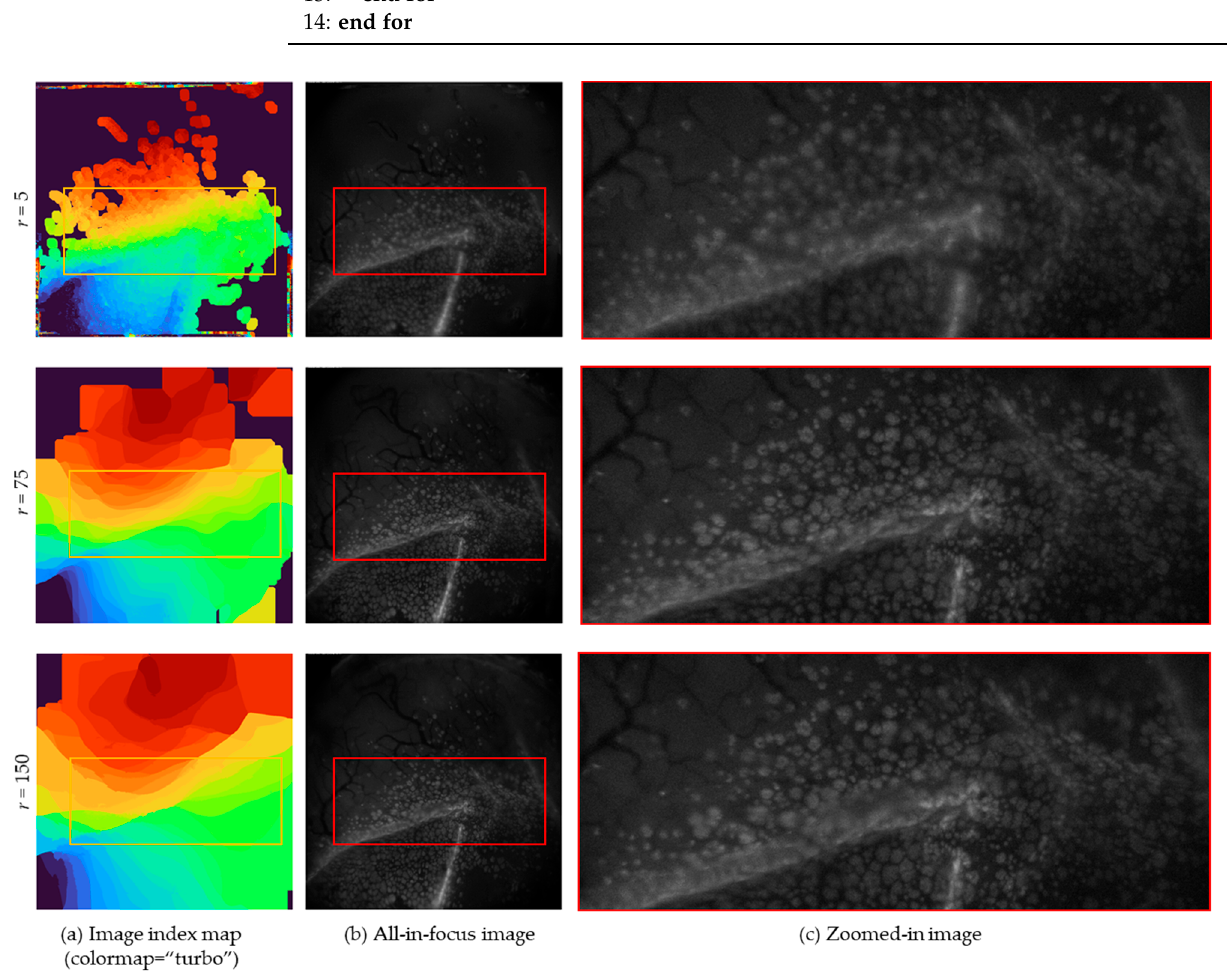
Figure 3. Image index map and processed results for different values of the window size r . Each column is separated by a r . ( b ) All-in-focus images that are fused based on image index maps in ( a ). The marked areas highlighted by the red box in ( b ) represent the zoomed-in images ( c ). By adjusting r , the area affected by the filter is also adjusted. If r is 5, as shown in the first column, it did not properly express the boundary features. In the third column, most areas in the image index map are indexed. Since information is extracted from a wide area, there is a disadvantage of obtaining information in an out-of-focus area. As shown in the second column, by choosing an appropriate r , a clear fusion result can be obtained without loss of features.